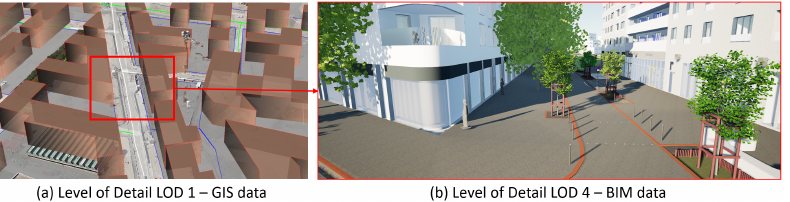
Figure 2. Level of detail of GIS- and BIM-based 3D models. ( a ) GIS city models are 2.5D models: footprint plus elevation, with textures. ( b ) An immersive visit requires a high level of